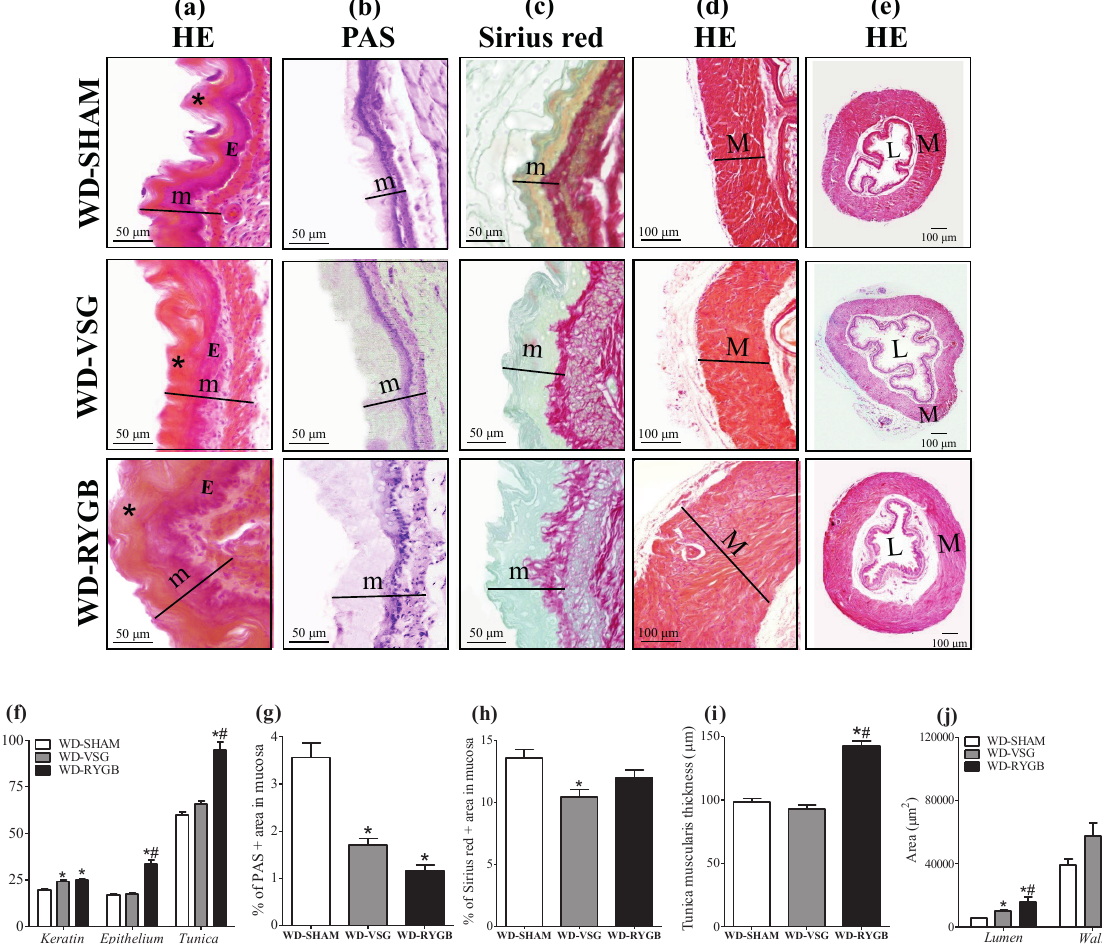
Figure 4. Representative images of 5-μm-thick sections of the lower esophagus of WD-SHAM, WD-VSG and WD- RYGB rats, at 3 months after operations. Sections were stained with HE (a, d and e; * = keratin layer; E = epithelium layer; m = tunica mucosa; M = tunica muscularis; L = lumen), or periodic acid Schiff (PAS; B; m = tunica mucosa) or sirius red (C; m = tunica mucosa). Scale bars = 50 or 100 μm. Means ± SEM of the keratin layer, epithelium and tunica mucosa (f), percentage of PAS (g) or Sirius red (h) positive areas in the tunica mucosa, thickness of tunica muscularis (i), and lumen and wall circumference area (j) of the lower esophagus; of total tunica mucosa (d), tunica muscularis (e) and tunica adventitia (f) thickness in the lower esophagus of WD-SHAM (n = 5), WD-VSG (n = 5) and WD-RYGB (n = 5) rats. *different from WD-SHAM; #different from the other type of bariatric operation (Kruskal- Wallis followed by Dunns post test, P <